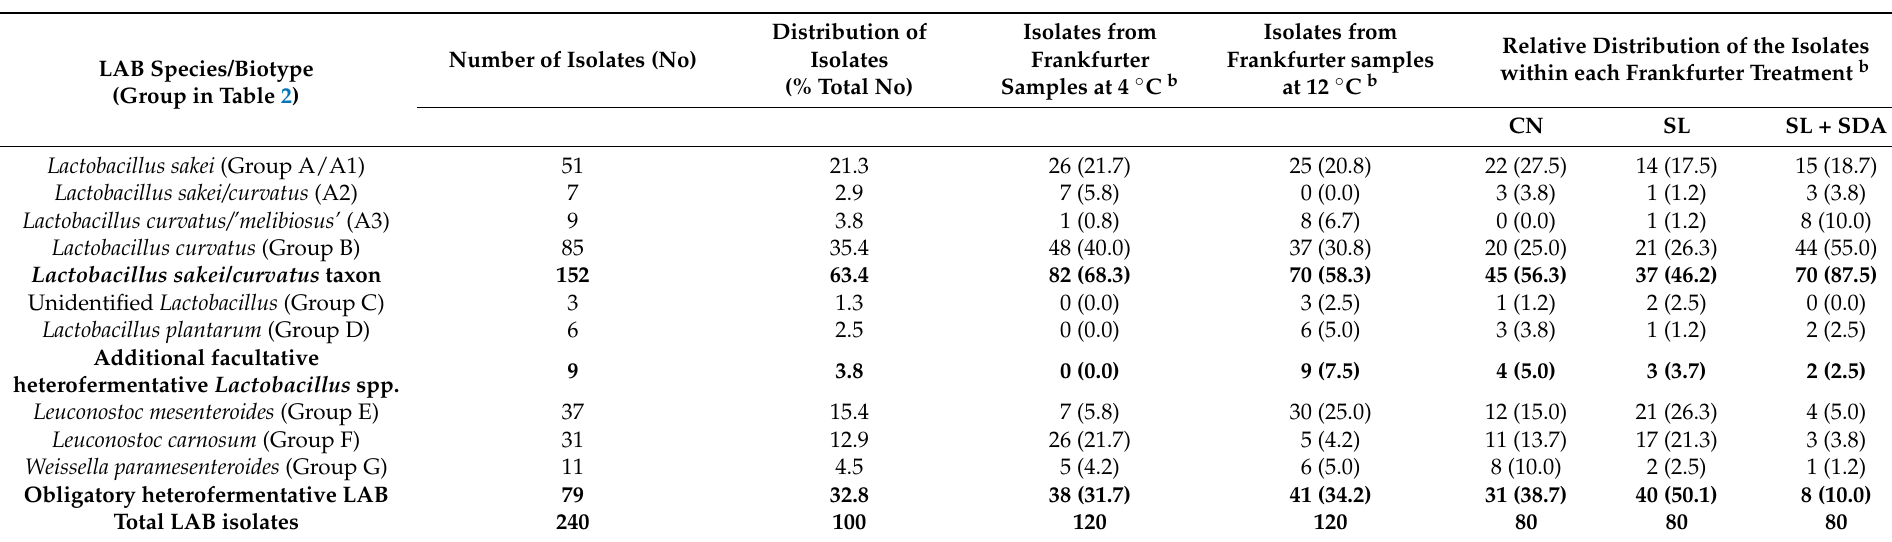
Table 3. Distribution of the identified LAB isolates in frankfurters formulated with or without organic acid salts, vacuum packaged and stored at 4 ◦ C or 12 ◦ C a .